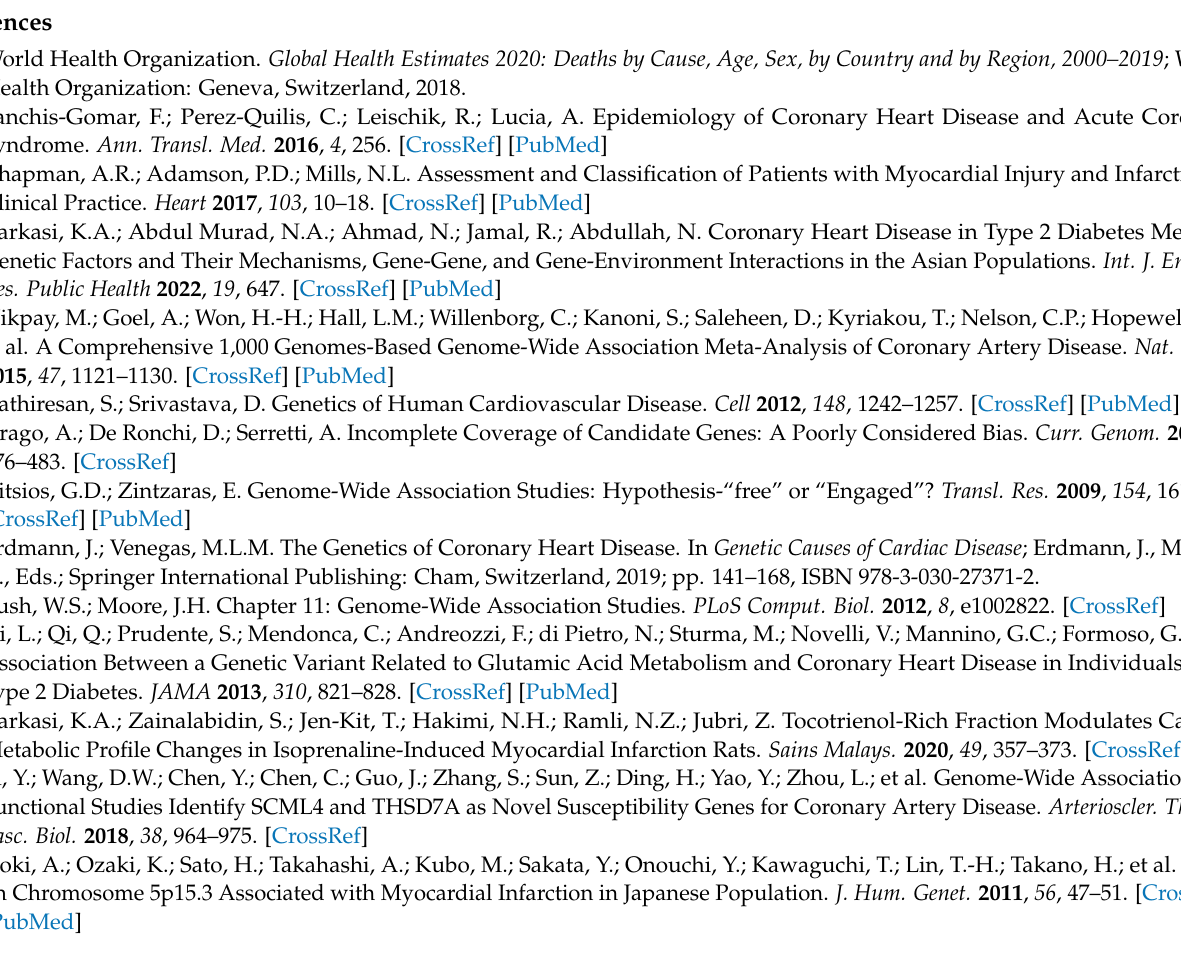
the 44 included articles; Table S2: Meta-analysis results of the recurring SNPs; Table S3: Significant meta-analyzed SNPs and their corresponding gene(s); Table S4: Results of significant pathways in the Pathway Enrichment Analysis using